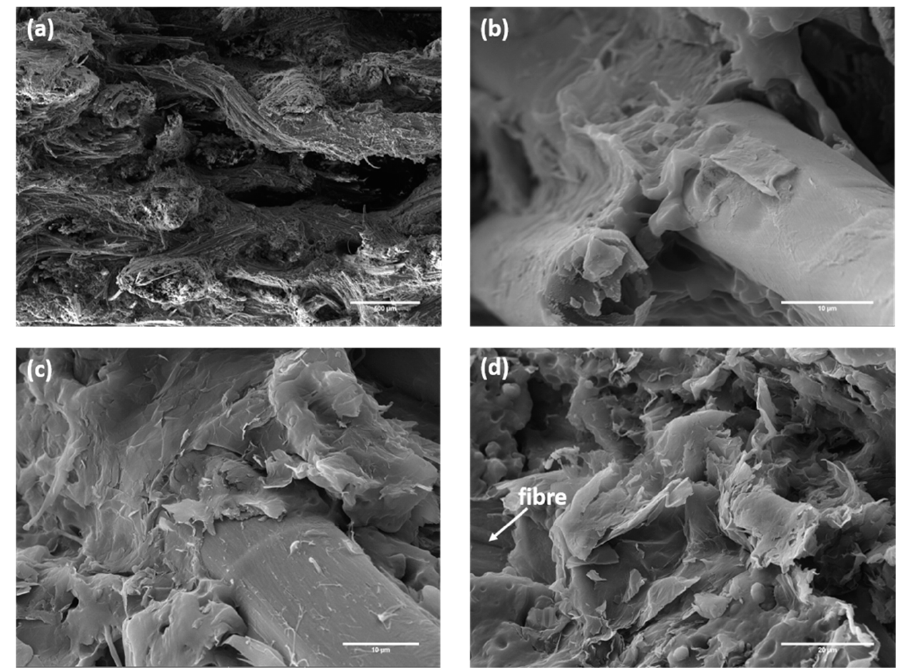
Figure 9. SEMmicrographsofthefracturesurfacesofPPC / Flax_GNPcompositesatdifferentmagnifications. Figure 9. SEM micrographs of the fracture surfaces of PPC/Flax_GNP composites at different magnifications.